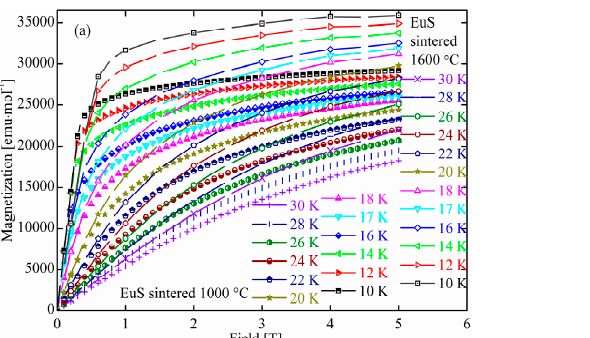
Figure 2. The relationship between FH and FC magnetization of the prepared EuS and tempera- ture: ( a ) the temperature dependence of magnetization M(T); ( b ) the inverse susceptibility curve, 1/ χ , for sintered polycrystalline EuS; the magnetic data of single-crystal EuS along (100) and (110) directions [13] were added to compare the difference between single-crystal and polycrystalline EuS magnetic data .